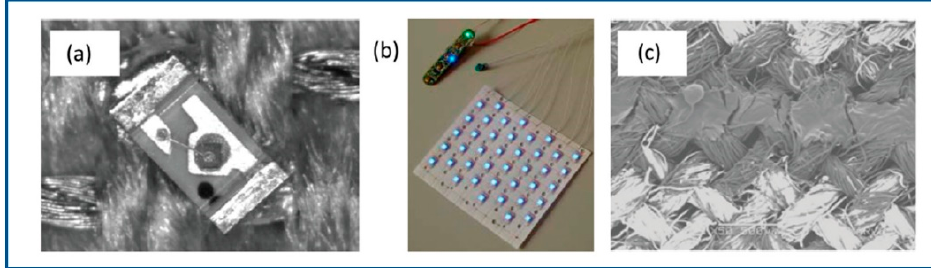
Figure 6. ( a ) Microcontacting and LED using a conductive adhesive, ( b ) functional LEDs on a woven narrow fabric, and ( c ) a printed PEDOT line on the fabric used in a strain sensor. The figures were obtained under kindly permission of [40]. The same legend from the original study was maintained.